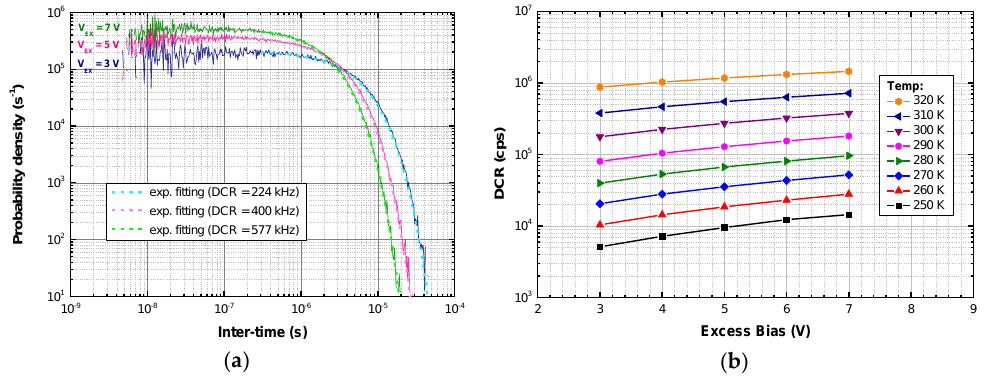
Figure 5. ( a ) Inter-time probability density for a shallow SiPM: the primary DCR is the inverse of the exponential fitting time constant; ( b ) Primary DCR of a deep SiPM, as a function of excess bias, at different temperatures.